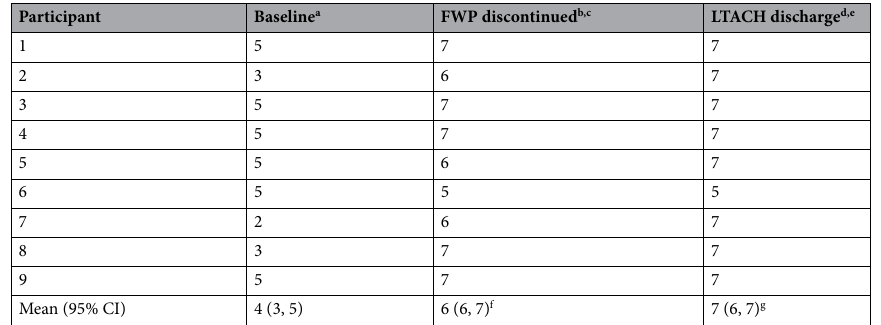
Table 6. Functional oral intake scale (FOIS). a Collected prior to the days 1–3 baseline collection period; b Collected once the FWP was discontinued due to improvements, discharge, or destabilization; c FWP free water protocol; d Collected at time of participant discharge; e LTACH long term acute care hospital; f Significantly different compared to baseline using Kruskal Wallis Test; P = 0.0039; g Significantly different compared to baseline using Kruskal–Wallis ANOVA and Dunn’s Multiple Comparison Test; P =